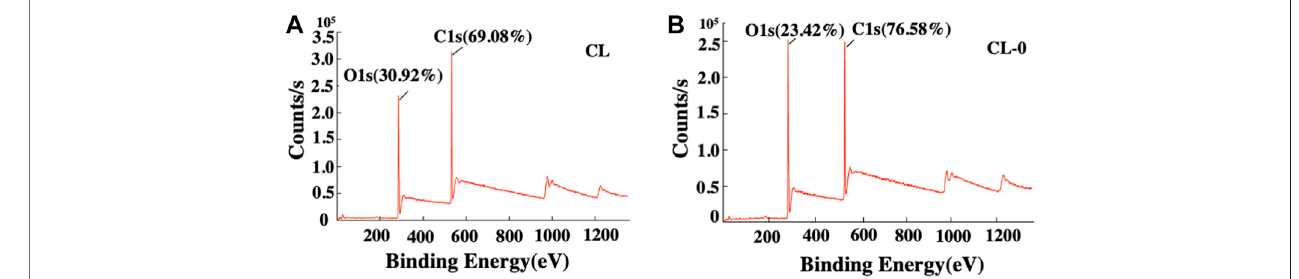
FIGURE 2 | Elemental analysis of the contact lenses CL (A) and CL-0 (B) .